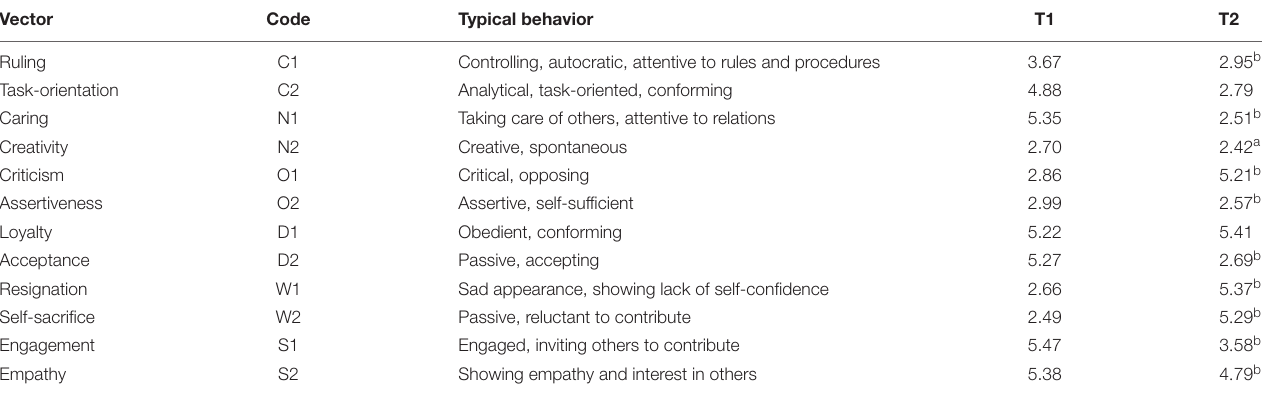
TABLE 4 | Differences in perceived work culture in a municipality (2) without implementation of